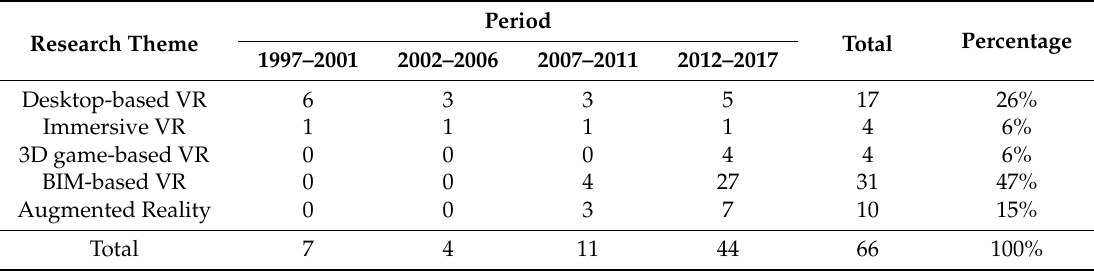
Table 3. The distribution of publications characterized by technology and publication